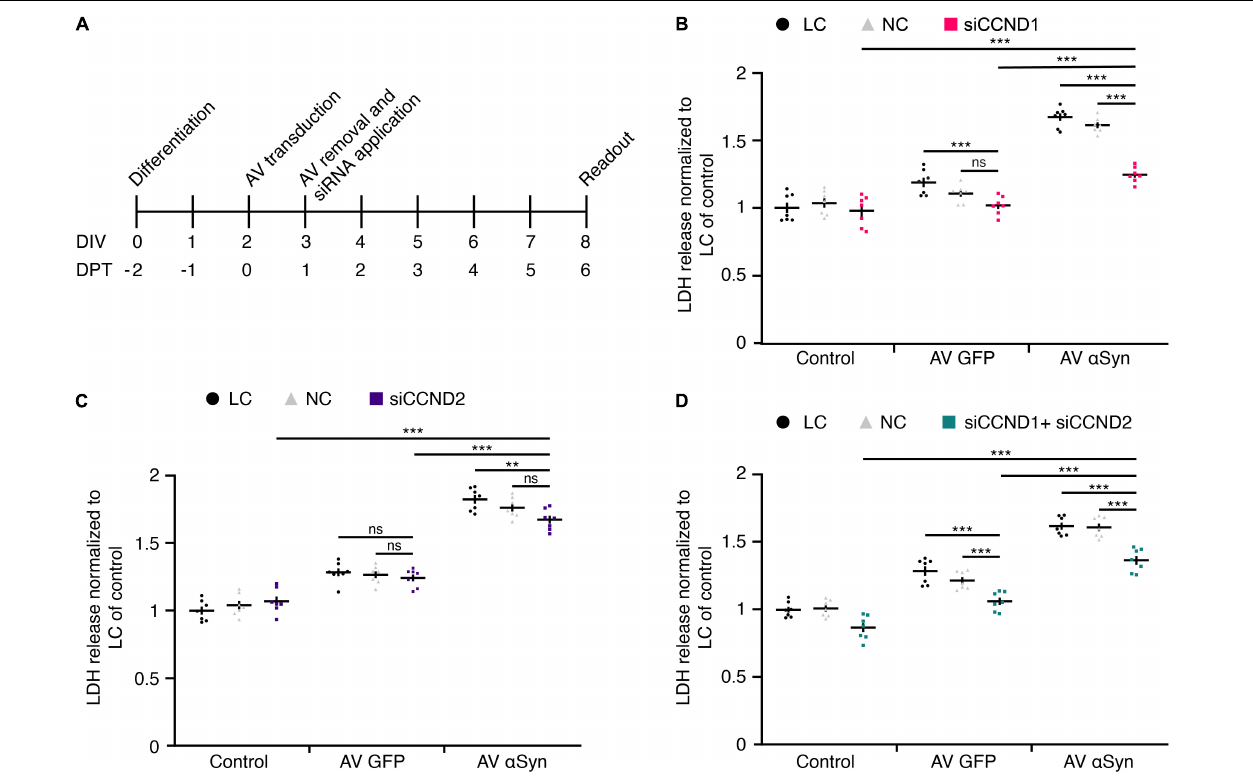
FIGURE 5 | Functional siRNA analysis. (A) Experimental treatment scheme. LUHMES neurons were transduced with adenoviral (AV) vectors of SNCA or GFP (control virus) and treated with or without siRNAs against CCND1 and/or CCND2 . LDH release as measure for cytotoxicity was determined in control 6 days after transduction. DIV, days in vitro ; DPT, days post transduction. (B–D) Quantification of cytotoxicity upon treatment with siCCND1 (B) , siCCND2 (C) , and siCCND1 + siCCND2 (D) . Experiments in panels (B–D) included lipofectamine controls (LC), non-coding siRNA controls (NC) in parallel to the coding siRNA treatment. Data was normalized to LC in control cells. Results are presented as mean ± SEM from seven biological repeats. Statistical analysis in panels (B–D) was performed by a two-way ANOVA with Bonferroni’s correction for multiple testing and, if significant, pairwise comparisons were evaluated by an unpaired t -test. ** P < 0.01, *** P < 0.001; ns, not